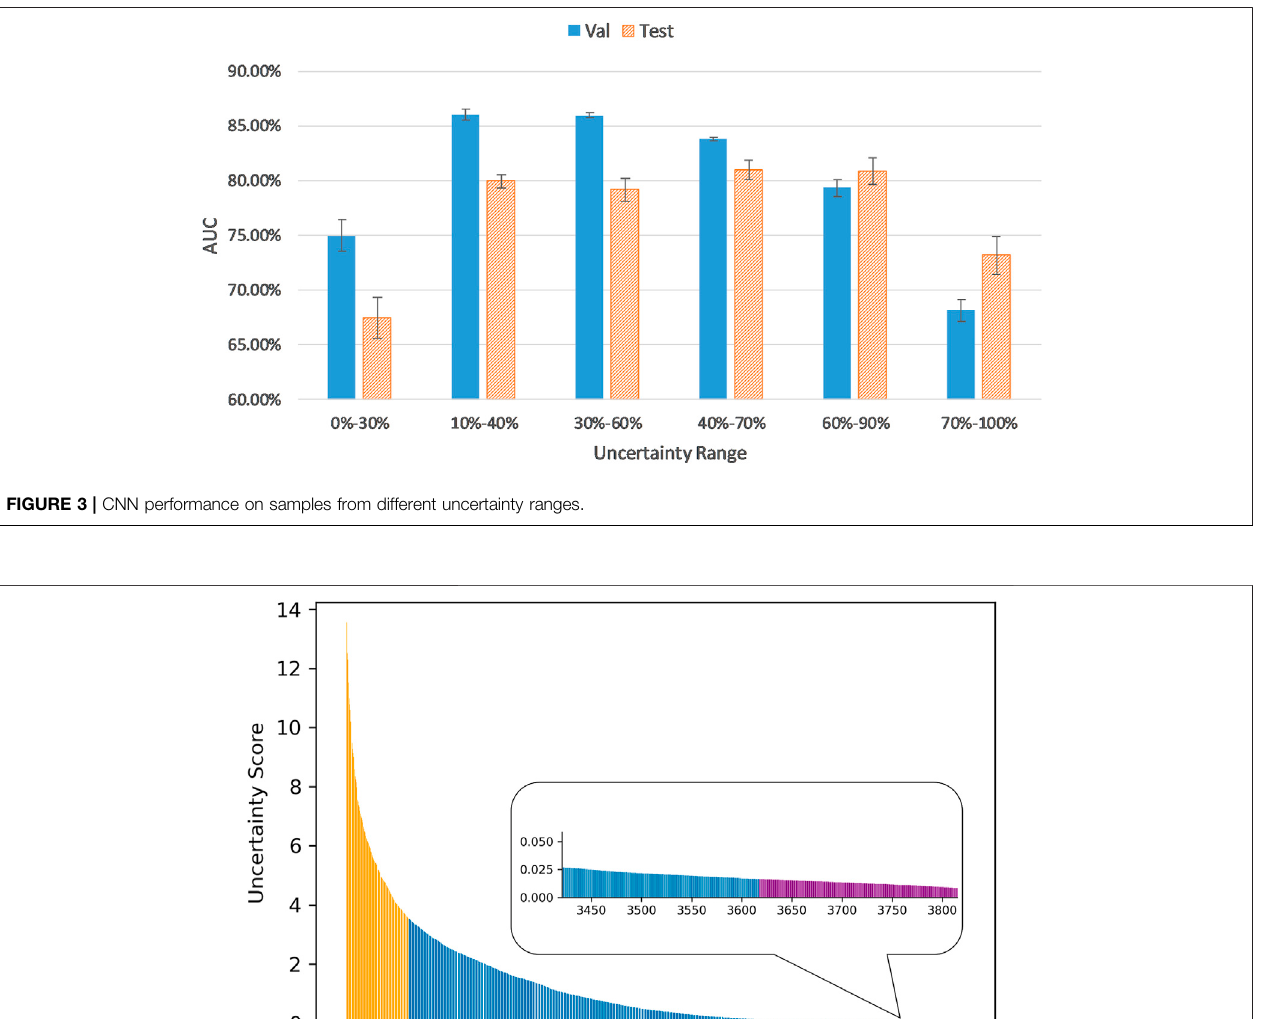
TABLE 3 | AUC results of the proposed method and baseline